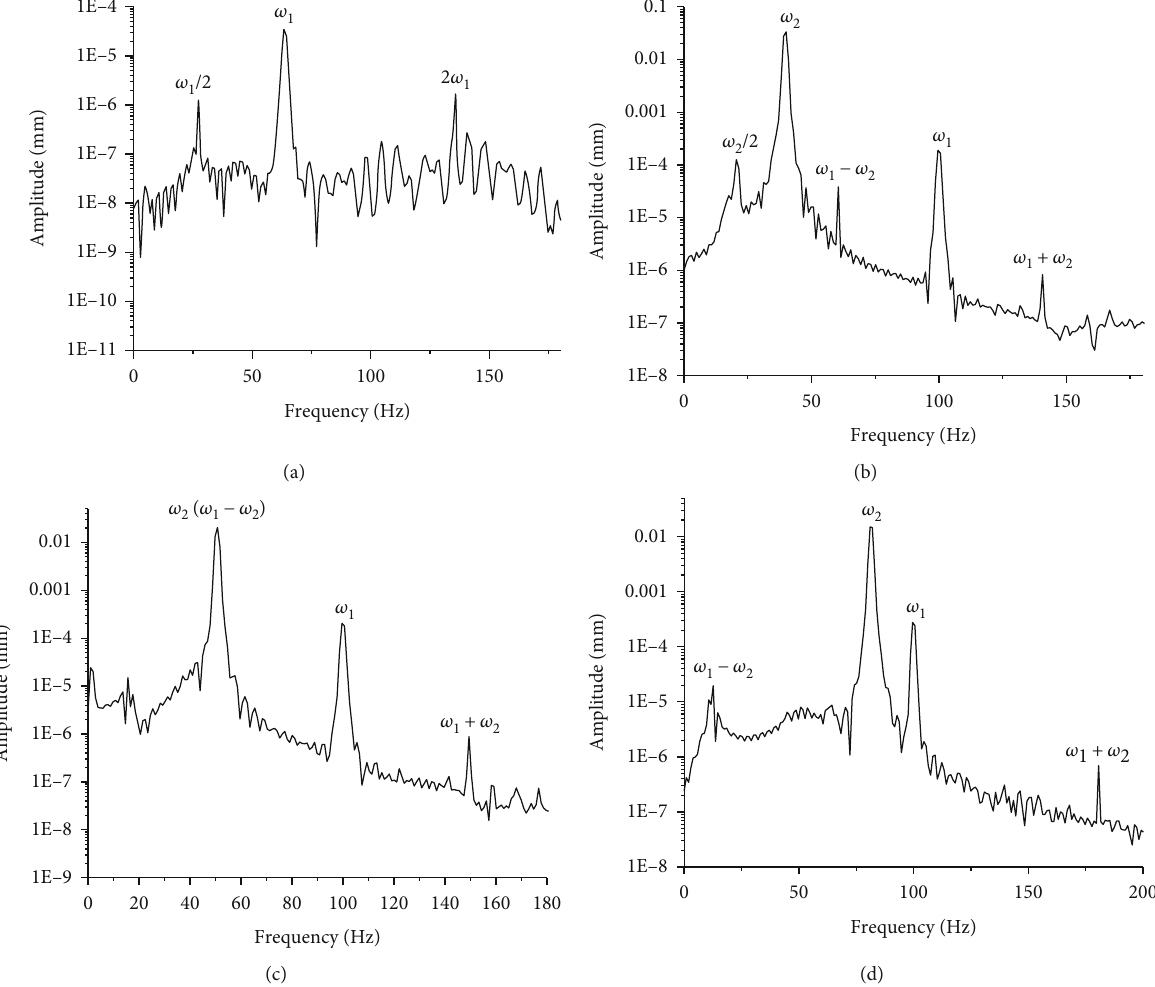
Figure 13: Simulation analysis results: the 2D spectrum map at di ff erent times: (a) 75 s; (b) 243s; (c) 282 s; (d) 310s.